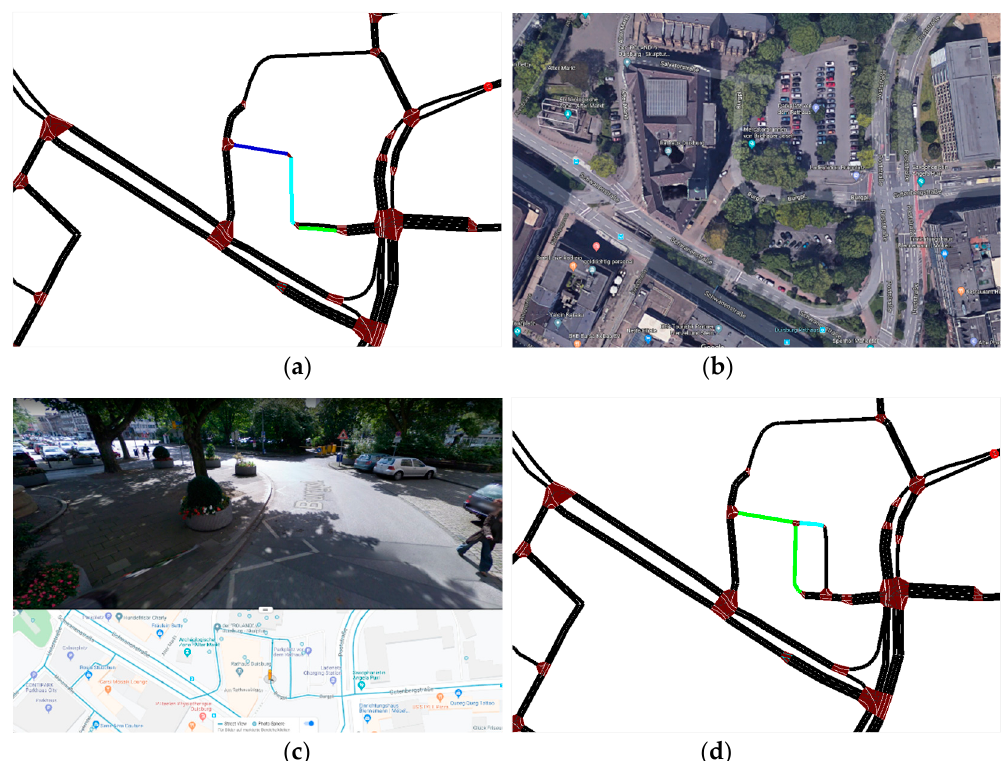
Figure 1. Example of a missing road in the road network. ( a ). Road network of the parking lot imported from Open Street Map (OSM). ( b ). Satellite map from Google map of the parking lot. ( c ). Street view from Google map, there is indeed a road missing in the imported map. ( d ). The missing road is manually added into the road network.